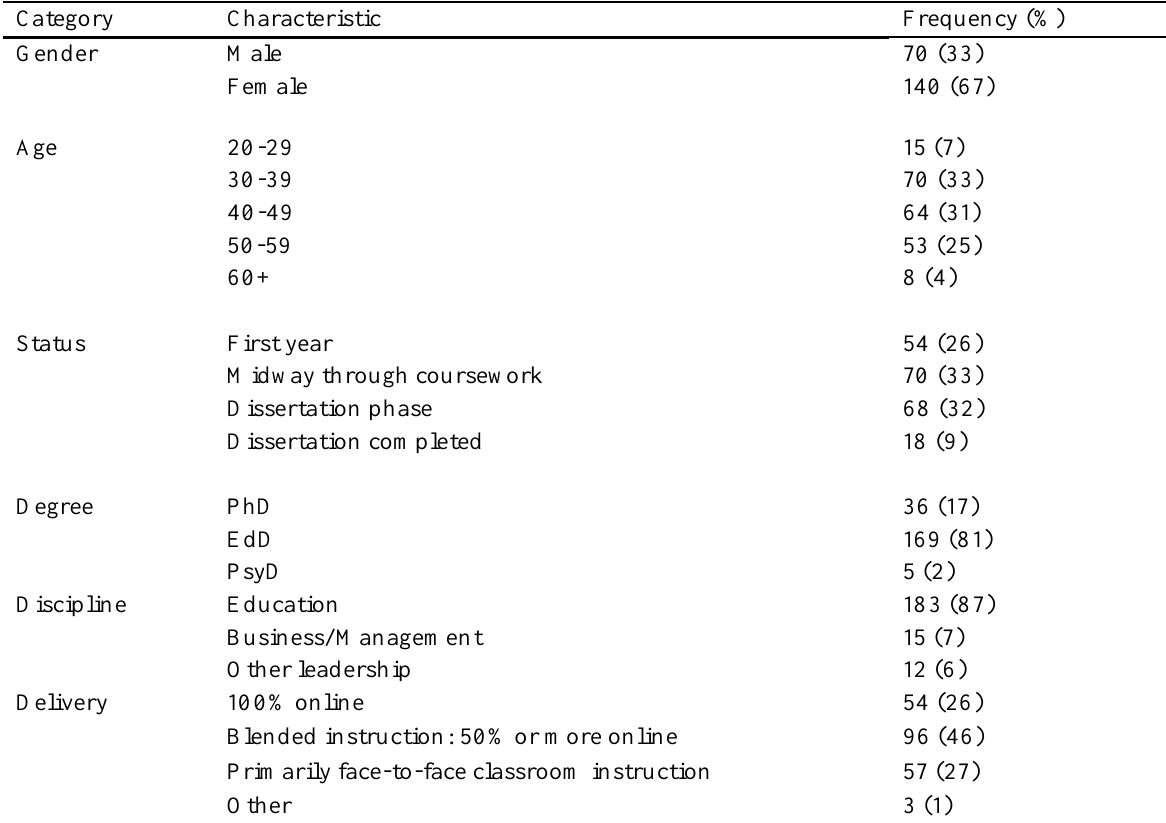
Participant Demographics (N = 210)